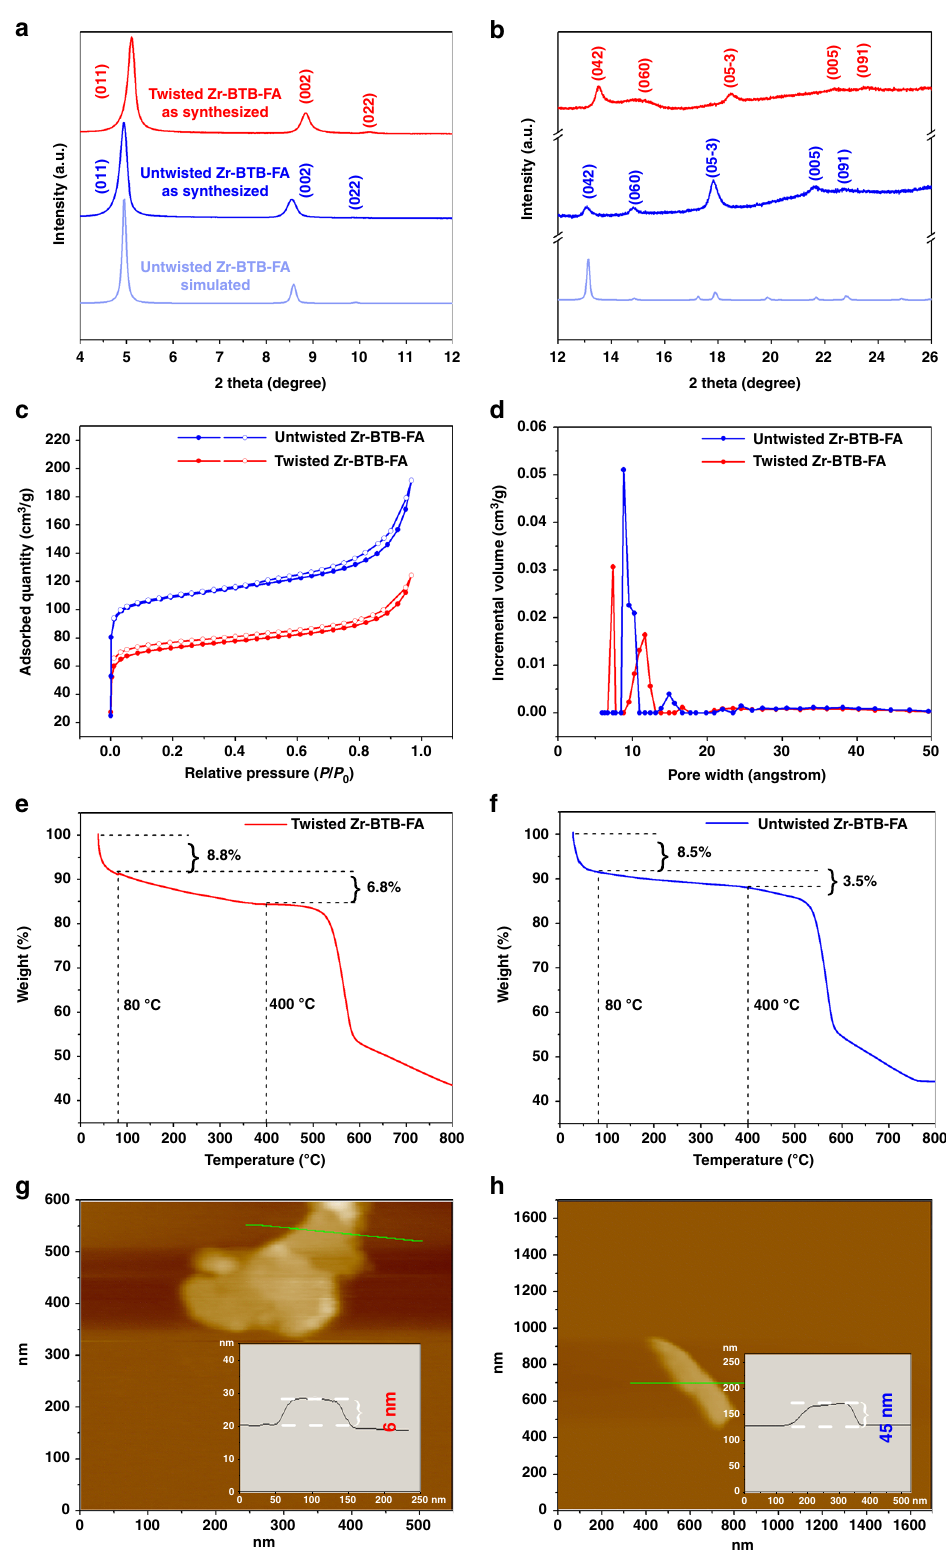
Fig. 3 Characterization of 2-D Zr-BTB-FA nanosheets. a , b PXRD patterns of twisted and untwisted Zr-BTB-FA nanosheets compared with simulation of twisted structures from preferred orientation (100), which obtained at a scan rate of 1° min − 1 . c N 2 adsorption-desorption isotherms of twisted and untwisted Zr-BTB-FA nanosheets. d Pore size distributions calculated via NLDFT method for twisted and untwisted Zr-BTB-FA nanosheets. e , f TGA curves of twisted and untwisted Zr-BTB-FA nanosheets, respectively. g , h AFM images of twisted and untwisted Zr-BTB-FA nanosheets and inset shows height pro fi le along the green line, respectively